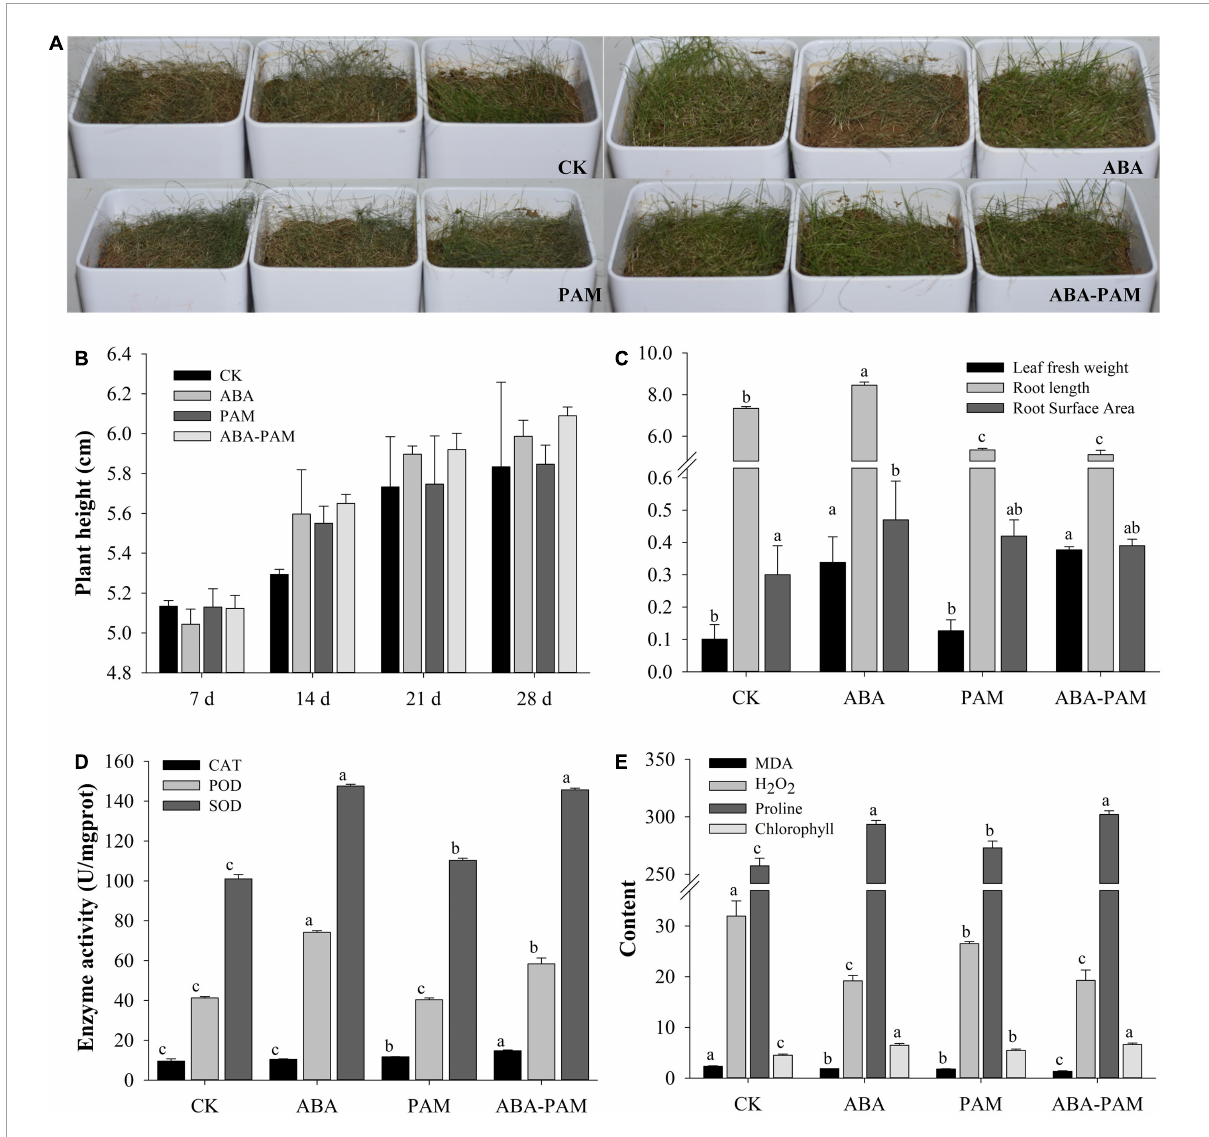
FIGURE1 Effect of ABA-PAM combined treatment on the growth of grasses. Drought-stressed forage grasses were treated with ABA and/or PAM (A) , and plant height were measured at different time points (B) . After the treatment period (63 days), the whole plants were uprooted and washed. The fresh weight, root weight, and root length were measured (C) . Leaf catalase (CAT), peroxidase (POD), superoxide dismutase (SOD), malondialdehyde (MDA), H 2 O 2 , proline, and chlorophyll contents were determined (D,E) . The units for MDA, H 2 O 2 , proline, and